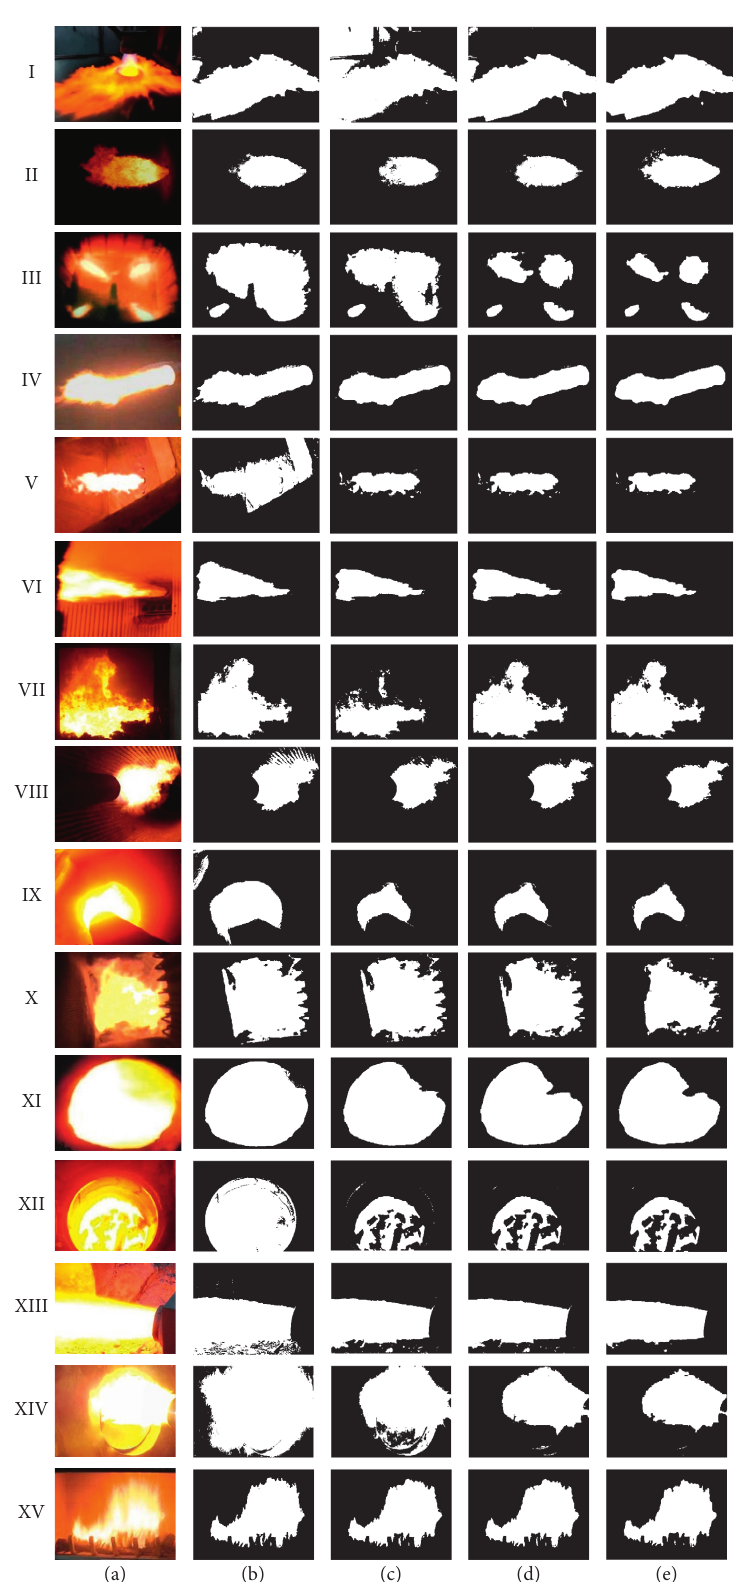
Figure 8: The comparison results of flame segmentation of original images I–XV: (a) original images I-XV; (b) results from SCM; (c) results from ICA-KCM; (d) results from NCTCSM; (e) results from proposed